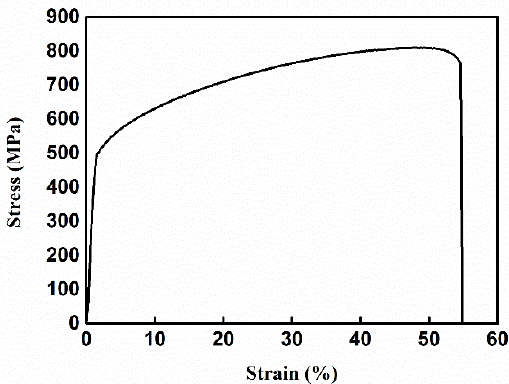
Figure 2. The stress-strain curve of the GH4169 alloy.